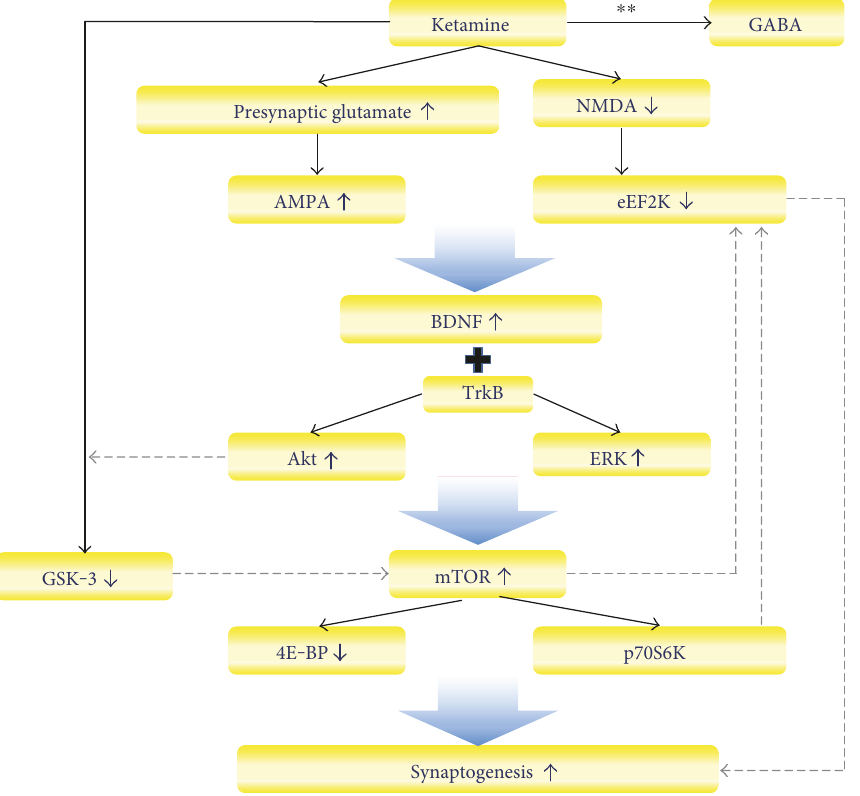
Figure 1: The hypothesized mechanism of ketamine ’ s antidepressant e ff ect. Ketamine increases AMPA receptor activities and suppresses NMDA receptor activities, which lead to activation of BDNF activity. The BDNF-TrkB signalling activates Akt and ERK pathways, which stimulate mTOR signalling. mTOR signalling increases synaptic protein synthesis by inhibiting 4E-BP and phosphorylating p70S6K. Ketamine also inhibits GSK-3 activity and may interact with GABA. ∗ Dash line: the interaction was known in other studies, but it is still unclear in the mechanism of ketamine ’ s antidepressant e ff ect. ∗∗ The interaction is still unclear because the study results are inconsistent. AMPA: α -amino-3-hydroxy-5-methyl-4-isoxazolepropionic acid; NMDA: N-methyl-D-aspartate; eEF2K: elongation factor-2 kinase; BDNF: brain-derived neurotrophic factor; TrkB: tropomyosin receptor kinase B; ERK: extracellular signal-regulated kinases; mTOR: mammalian target of rapamycin; 4E-BP: 4E binding proteins; p70S6K: p70 S6 kinase; GSK-3: glycogen synthase kinase-3; GABA: γ -aminobutyric